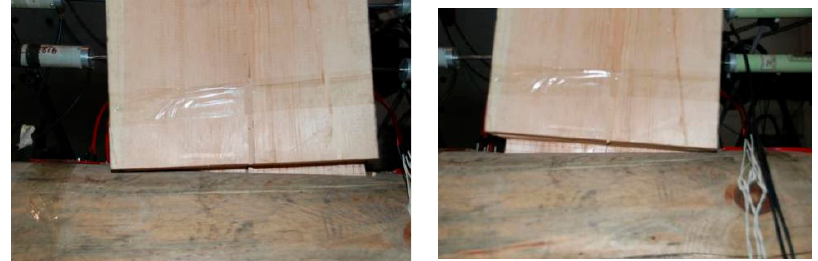
Figure 17. Slipping of the tenon. Figure 18. Pulling-out of the tenon. Figure 18. Pulling-out of the tenon.